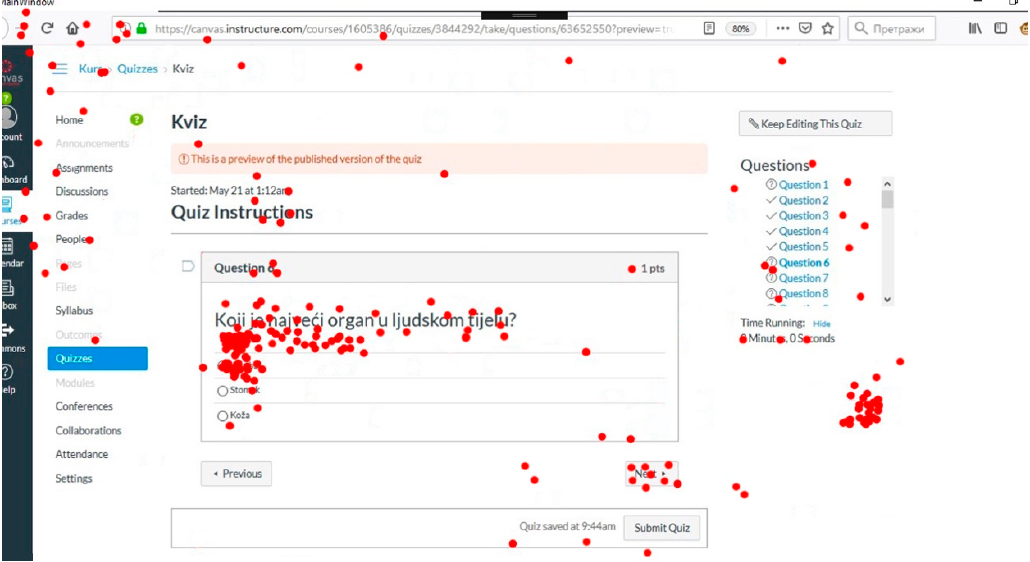
Figure 1. Student’s eye activity during the quiz.